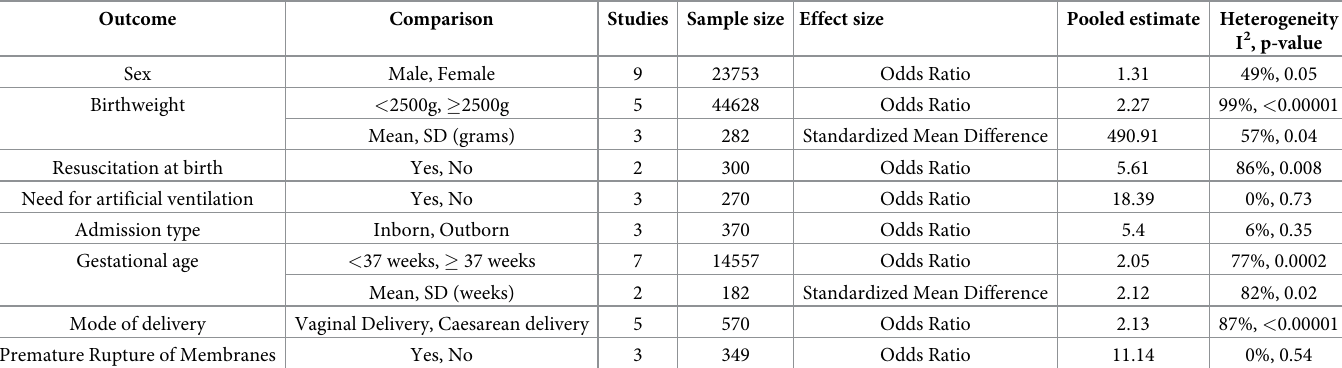
Table 2. Risk factors included in meta-analysis for neonatal sepsis.